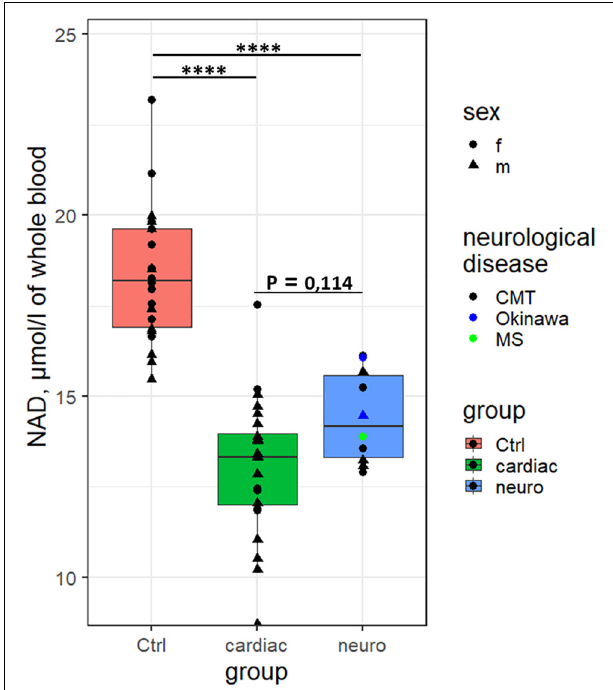
FIGURE 1 | Differences in the concentration of NAD + in the whole blood between the control subjects ( n = 22), the cardiological ( n = 24, excluding the four outliers) and neurological ( n = 10) patients. ∗∗∗∗ p < 0.0001.